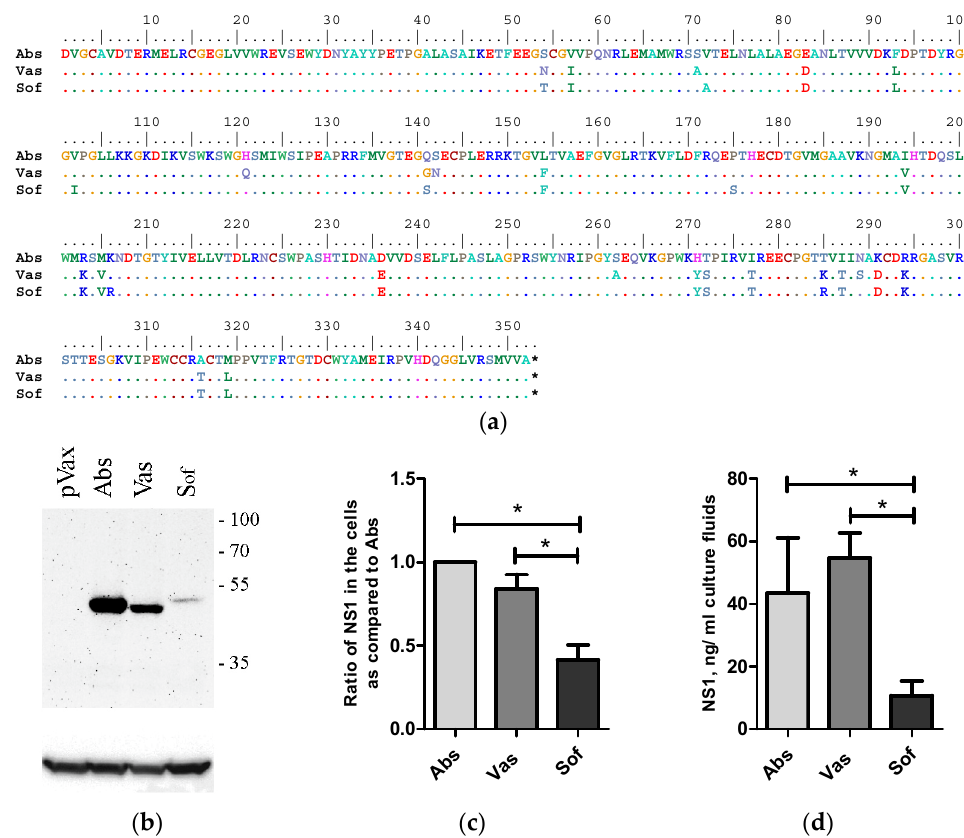
Figure 1. Alignment and expression of NS1 of strains of three TBEV subtypes in 4T1 cells. Alignment of NS1 of strains Absettarov (Abs) of the European subtype, Vasilchenko (Vas) of the Siberian subtype and Sofjin-Chumakov (Sof) of the Far-Eastern subtype ( a ). 4T1 cells were transfected with the plasmid-encoded NS1 of strains Absettarov (Abs) of the European subtype, Vasilchenko (Vas) of Siberian subtype and Sofjin-Chumakov (Sof) of the Far-Eastern subtype or pVax vector. After two days, the cells were lysed and analyzed by Western blot with anti-NS1 antibodies clone 4C4 ( b ); the positions of molecular mass markers are given on the right in kDa. The ratio of NS1 amount in cells normalized to actin as compared to Abs (data of more than 3 repeats were present) ( c ). The amount of NS1 secreted into cell culture fluids was measured by ELISA ( d ). Statistically significant differences (* p < 0.05) were derived by the Student’s t -test.